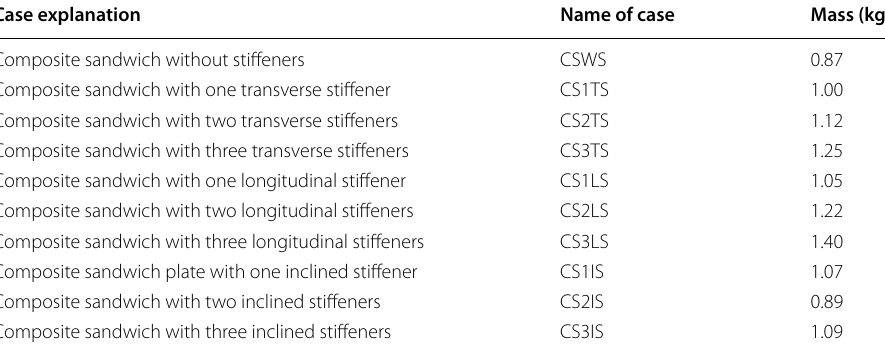
Table 2 Case details for sandwich composite plates with the different alignment of stiffeners Case explanation Name of case Mass (kg) Composite sandwich without stiffeners CSWS